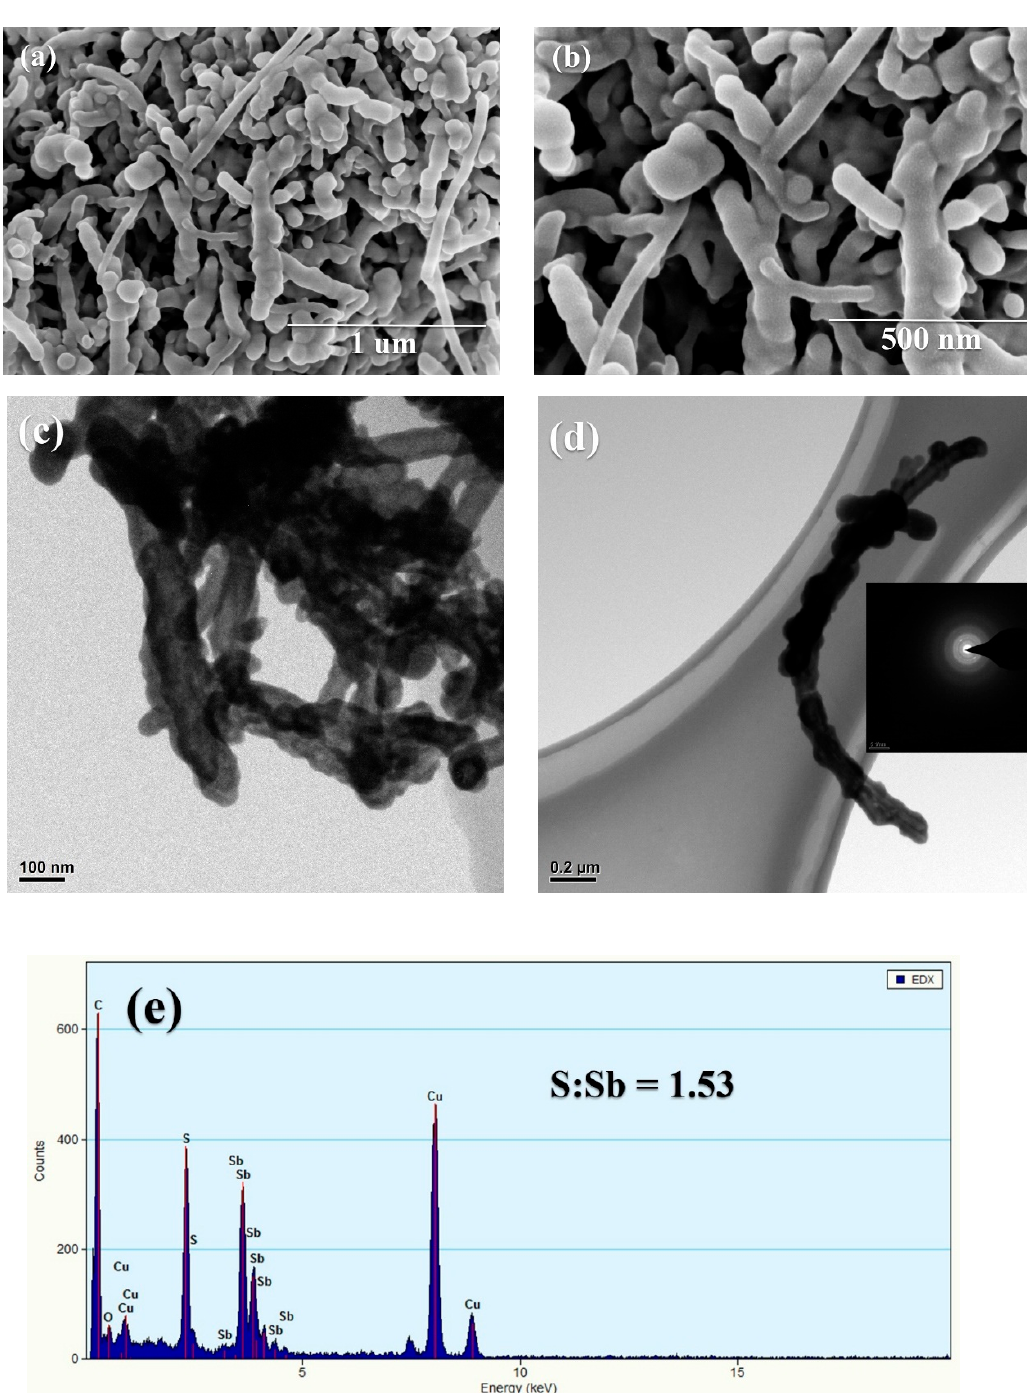
Figure 1. XRD patterns of the as-prepared Sb 2 S 3 /carbon nanotube (CNT) nanocomposites, pure Sb 2 S 3 and CNTs.